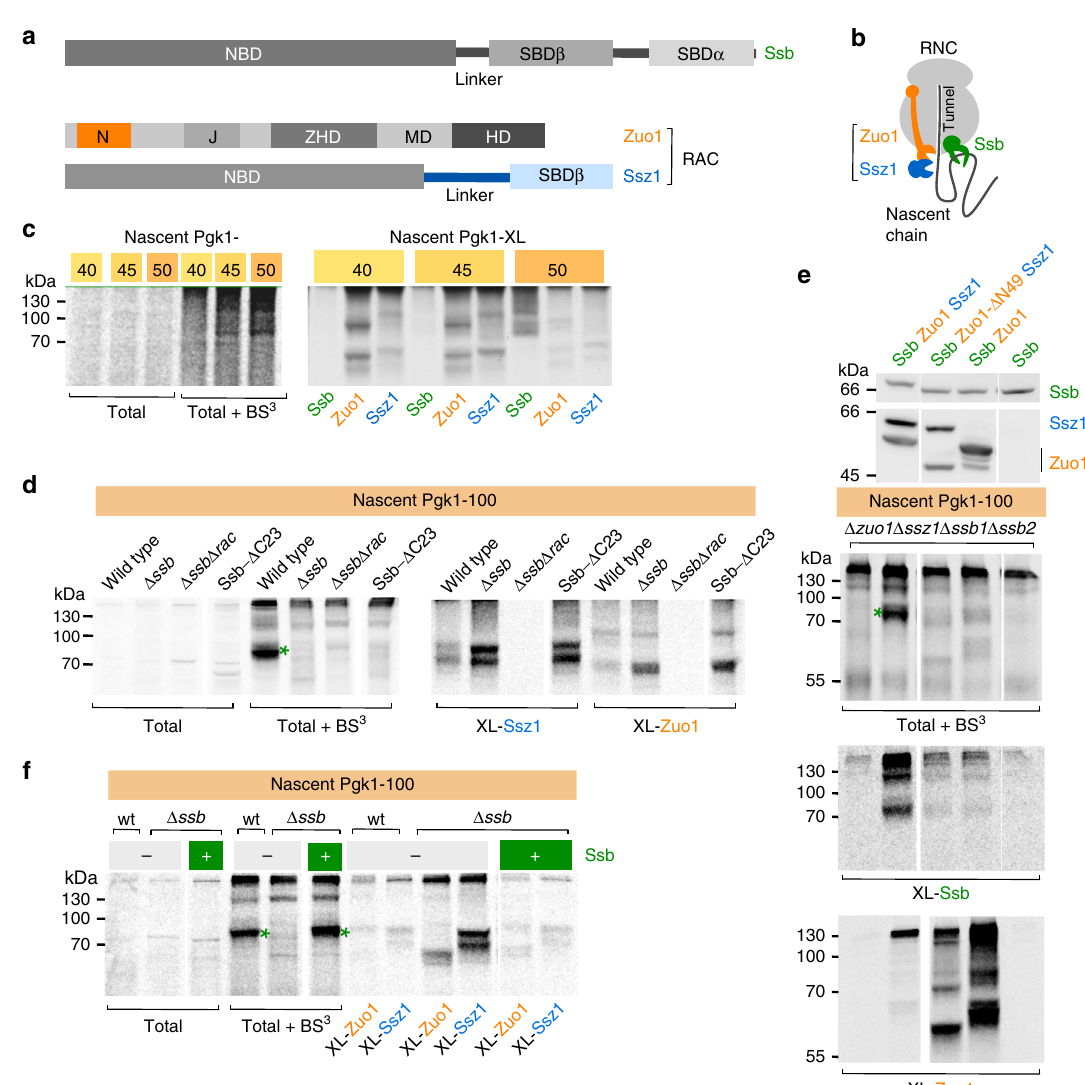
Fig. 1 Zuo1 and Ssz1 contact nascent chains prior to Ssb. a Domain structure of yeast Ssb, Zuo1, and Ssz1. Nucleotide binding domain (NBD), linker, substrate binding domain β (SBD β ), substrate binding domain α (SBD α ), N-terminal domain (N), J-domain (J), Zuo1 homology domain (ZHD), middle domain (MD), and four-helix bundle (HD). b Experimental set up of crosslinking experiments. Isolated RNCs carrying [ 35 S ]-labelled nascent chains are crosslinked to adjacent proteins using the homobifunctional amino-reactive crosslinker BS 3 , spacer length 11.4 Å. Crosslink products between nascent chains and Ssb, Ssz1, or Zuo1 are then identi fi ed via immunoprecipitation under denaturing conditions using antibodies directed against Ssb, Ssz1, or Zuo1. For details see Methods. c Contacts of Ssb, Zuo1, and Ssz1 with short nascent chains. RNCs carrying Pgk1-40 (40 residues), -45 (45 residues), or -50 (50 residues) were generated in a wild type translation extract as described in ( b ). Crosslink products (Pgk1-XL) between Ssb and nascent Pgk1 (Ssb); Zuo1 and nascent Pgk1 (Zuo1); and Ssz1 and nascent Pgk1 (Ssz1). d Zuo1 and Ssz1 interact with nascent Pgk1-100 (100 residues) in the absence of ribosome-bound Ssb. The experiment was performed as described in c using RNCs from wild type, Δ ssb1 Δ ssb2 ( Δ ssb) , Δ ssb1 Δ ssb2 Δ zuo1 Δ ssz1 ( Δ ssb Δ rac) , or Ssb1- Δ C23 translation extract. The green asterisk indicates the crosslink between Ssb and Pgk1-100 in the total ( d – f ). e Transfer of the nascent chain from Zuo1 to Ssb requires Ssz1. The experiment was performed as in ( c ) using RNCs from Δ zuo1 Δ ssz1 Δ ssb1 Δ ssb2 translation extract. Ribosome-free extracts (upper panel) obtained from wild type (Ssb, Zuo1, Ssz1), Δ zuo1 expressing Zuo1- Δ N49 (Ssb, Zuo1- Δ N49, Ssz1), Δ ssz1 (Ssb, Zuo1), Δ zuo1 Δ ssz1 (Ssb) were added after completion of translation reactions, prior to crosslinking. Rebinding of Ssb to RNCs was analyzed as described in Supplementary Fig. 1f. f Ssb prevents crosslinking of Zuo1 and Ssz1 to long nascent chains. The experiment was performed as in ( c ) using RNCs from wild type (wt) or Δ ssb1 Δ ssb2 ( Δ ssb) translation extract. Puri fi ed Ssb1 (Supplementary Fig. 1g,h) was added prior to the translation reaction as indicated ( + Ssb). Source data for ( c – e ) are provided as a Source Data fi